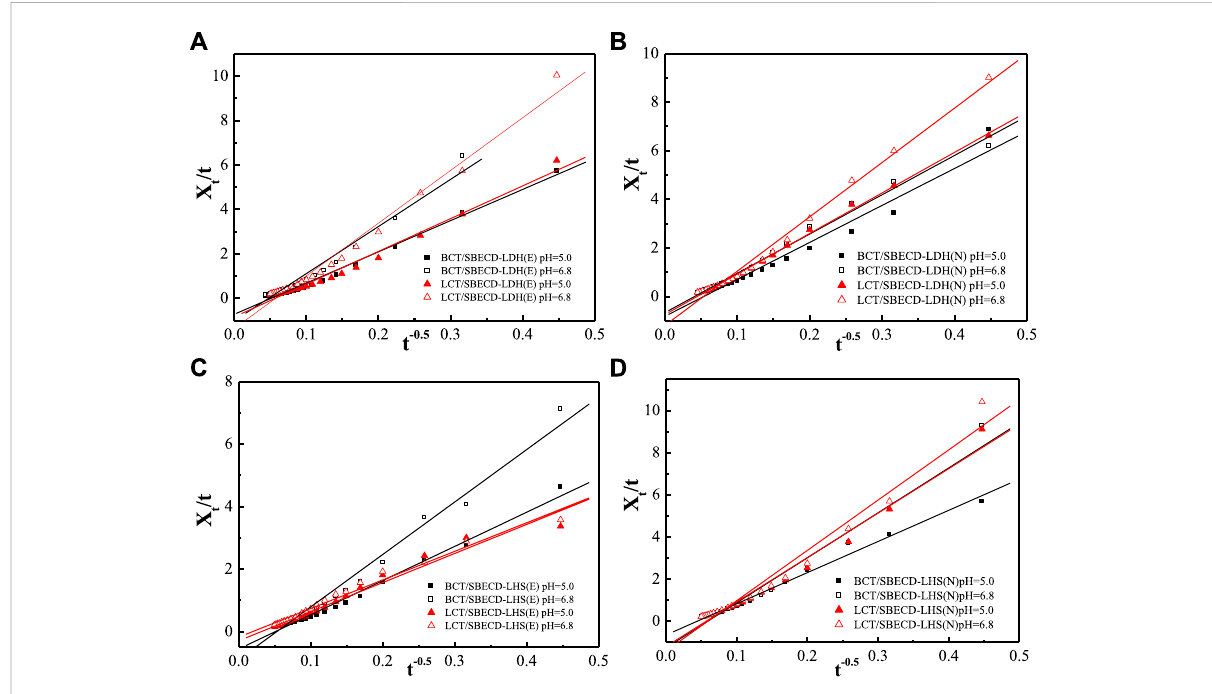
FIGURE 9 Regression curves of release data fi tting with parabolic diffusion model for LDH-hybrids (A,B) and LHS-hybrids (C,D) in different mediums.